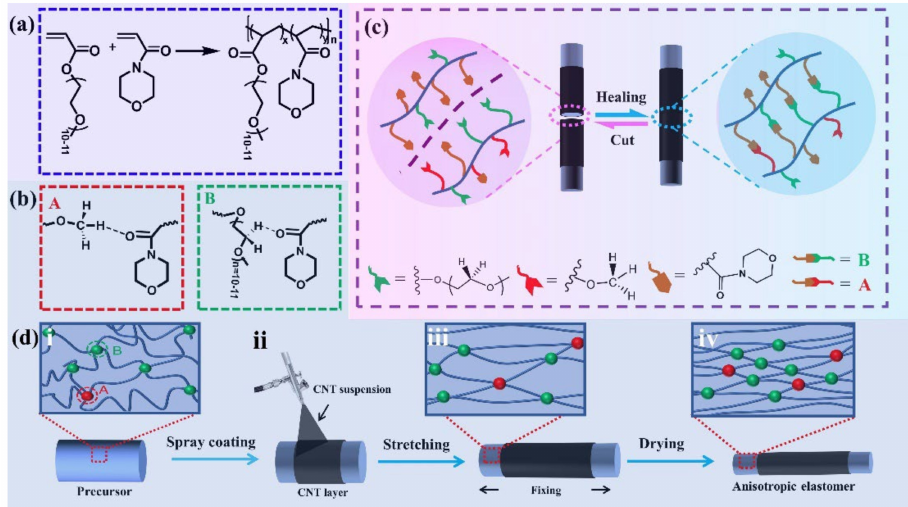
Figure 11. Illustrating the preparation and self-healing process of ultrafast self-healing elastomers coated with CNT layer and the corresponding self-healing mechanism. Free radical polymerization of acryloylmorpholine (ACMO) and PEG 480 methyl ether acrylate ( a ) to get cross-linked precursor hydrogel (i in ( d )), which can be dried under stretching (iii in ( d )) to produce self-healing elastomer (iv in ( d )) with anisotropic hierarchical structure and the reversible interaction of it were shown in A and B of ( b ). CNT coated self-healing electrodes was obtained by directly spray coating of CNT suspension on the surface of precursor hydrogel (ii), and then suferring fixed drying process as shown in (iii and iv). ( c ) The self-healing process of the obtained elastomer. Reproduced with permission from [122]. Copyright 2022 Elsevier